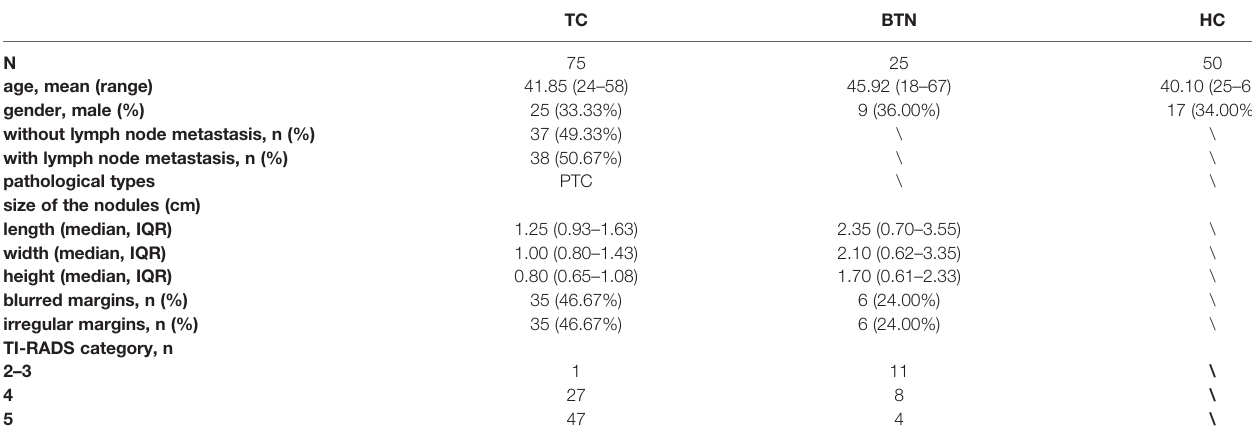
TABLE 1 | Clinicopathological characteristics of all participants by